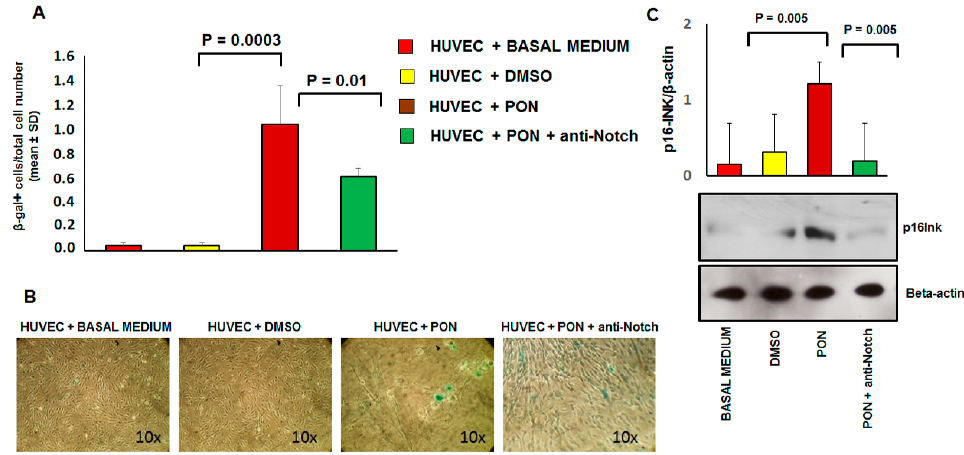
Figure 7. E ff ect of ponatinib and Notch-1 signaling inhibition on endothelial senescence. Panel ( A ), Quantitation of senescent cells in multiple microscope fields from HUVECs treated with 1.7 nM of ponatinib or DMSO, in the presence or absence of 1 µ g / mL of neutralizing factor anti-Notch-1 antibody. The graph, showing the ratio between the number of senescence-associated β -galactosidase positive cells and the total number of cells over 5 microscope fields per sample, represents quantification of three experiments ± standard deviation. Panel ( B ), representative SA- β -gal staining images of HUVECs treated with 1.7 nM of ponatinib or DMSO, in the presence or absence of 1 µ g / mL neutralizing factor anti-Notch-1 antibody, as indicated by blue staining. All images are shown at 10 × magnification. Panel ( C ), Western analysis of senescence marker p16INK4a in HUVECs treated with 1.7 nM of ponatinib or DMSO, in the presence or absence of 1 µ g / mL of neutralizing factor anti-Notch-1 antibody, with β -actin serving as a loading control. The bar graph represents for each value the mean ± S.D. from 3 separate